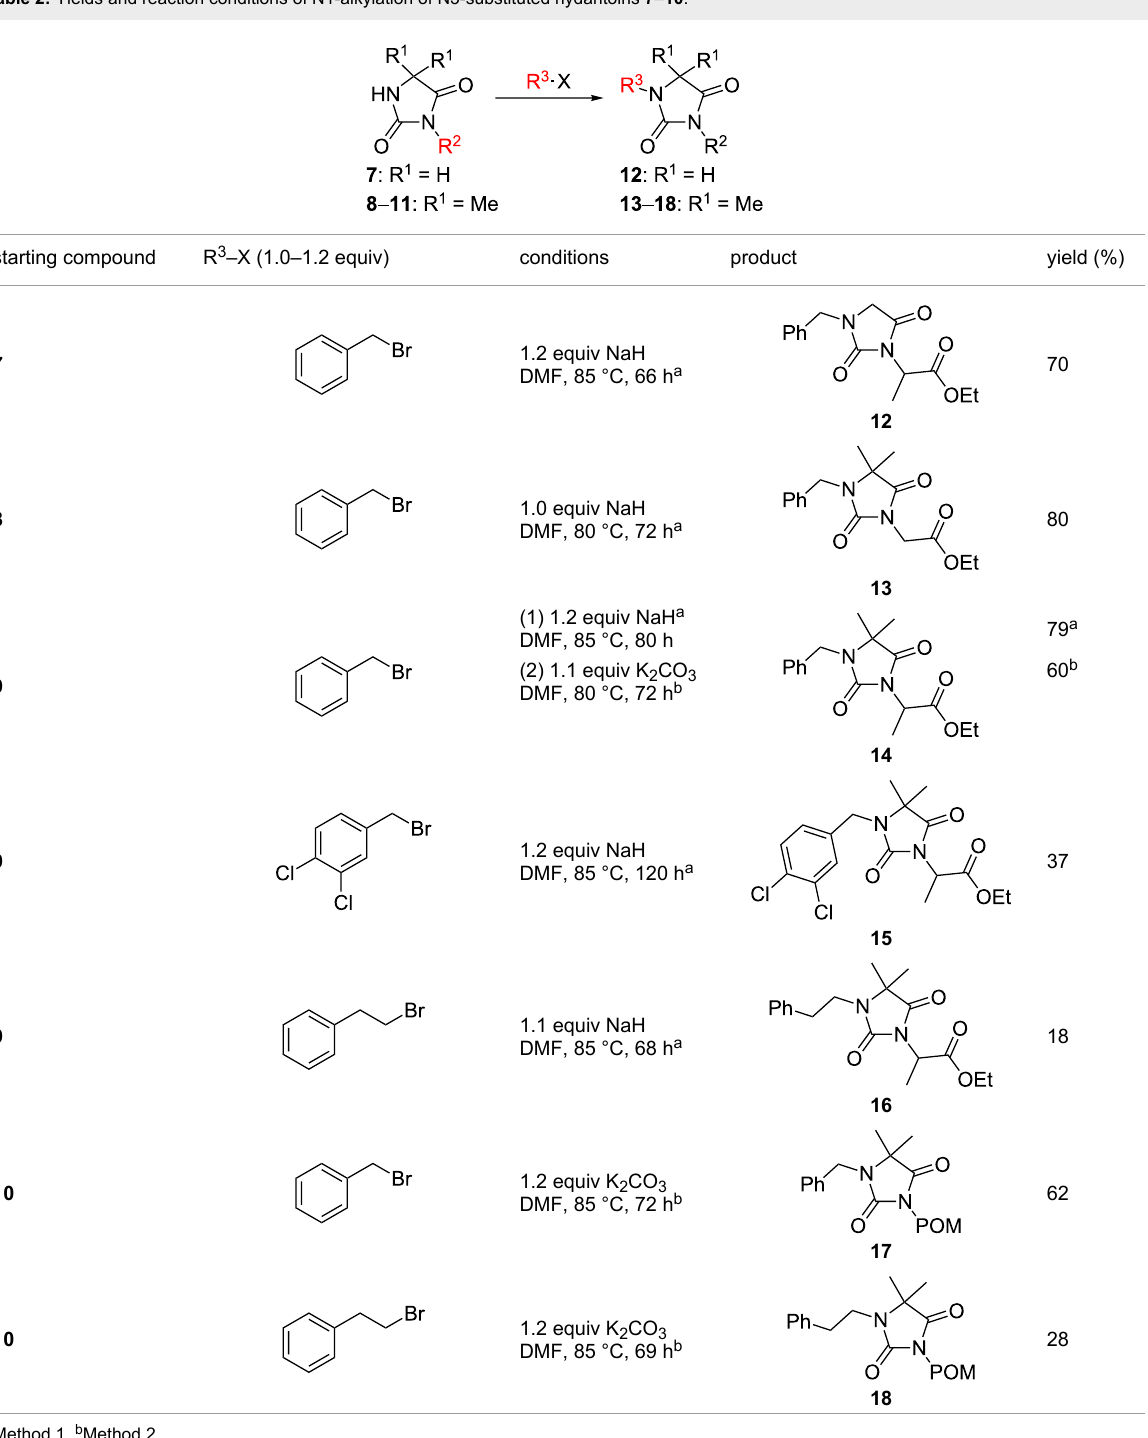
Table 2: Yields and reaction conditions of N1-alkylation of N3-substituted hydantoins 7 – 10 .